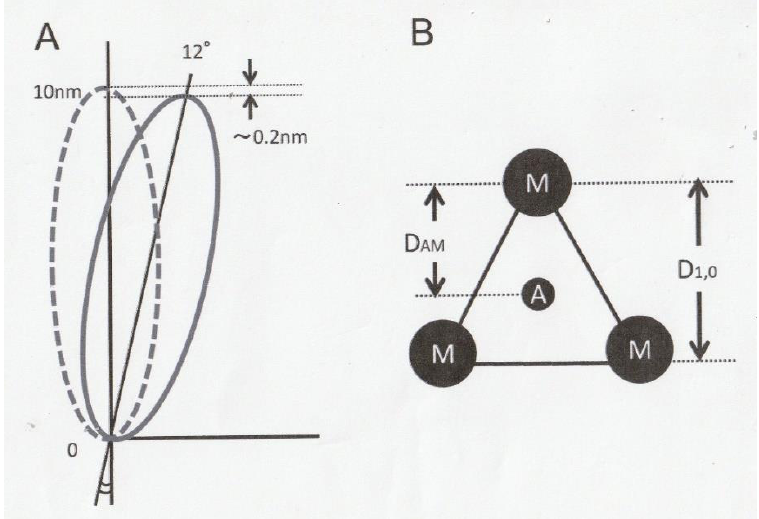
Figure 4. ( A ) Diagram illustrating tilting of myosin head (M) in response to ramp-shaped releases. Ramp-shaped releases are applied to the fiber in the direction from right to left, so that each myosin head CAD (10nm long) tilts around the base, i.e., the proximal end of myosin head CAD (0) from right (solid line) to left (broken line) around the proximal end of myosin head CAD (0). A fraction of the applied displacement (~2nm out of 5–6 nm/half sarcomere) is assumed to be taken up by tilting of each rigor myosin head CAD (long axis, 10nm) by 12°, from oblique (solid line) to perpendicular (broken line) configuration to actin and myosin filaments. Please note that after a release, the lateral distance between actin and myosin filaments, i.e., D A-M , increases by ~0.2nm. ( B ) Schematic diagram showing unit cell of myofilament lattice, in which an actin filament (A) is in trigonal position in an equilateral triangle formed by three myosin filaments (M).